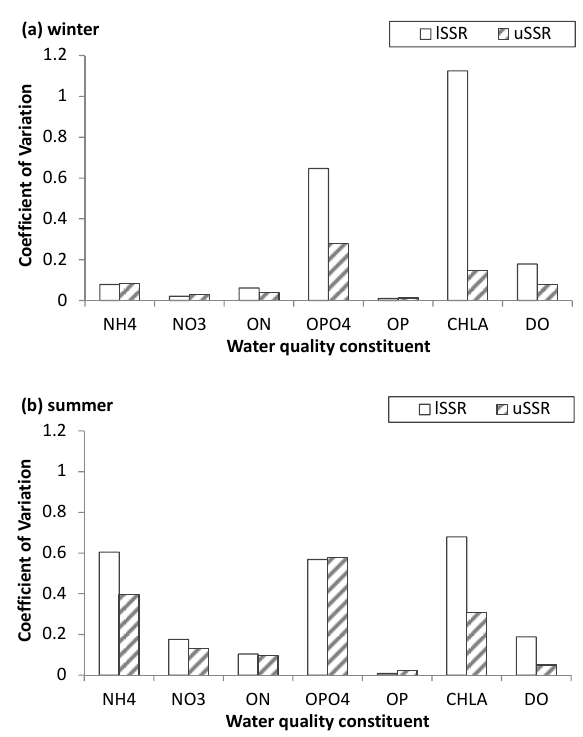
Figure 3. Uncertainty in water quality variables. ( a ) winter; ( b ) summer. Table 2. Sensitivity analysis in winter.